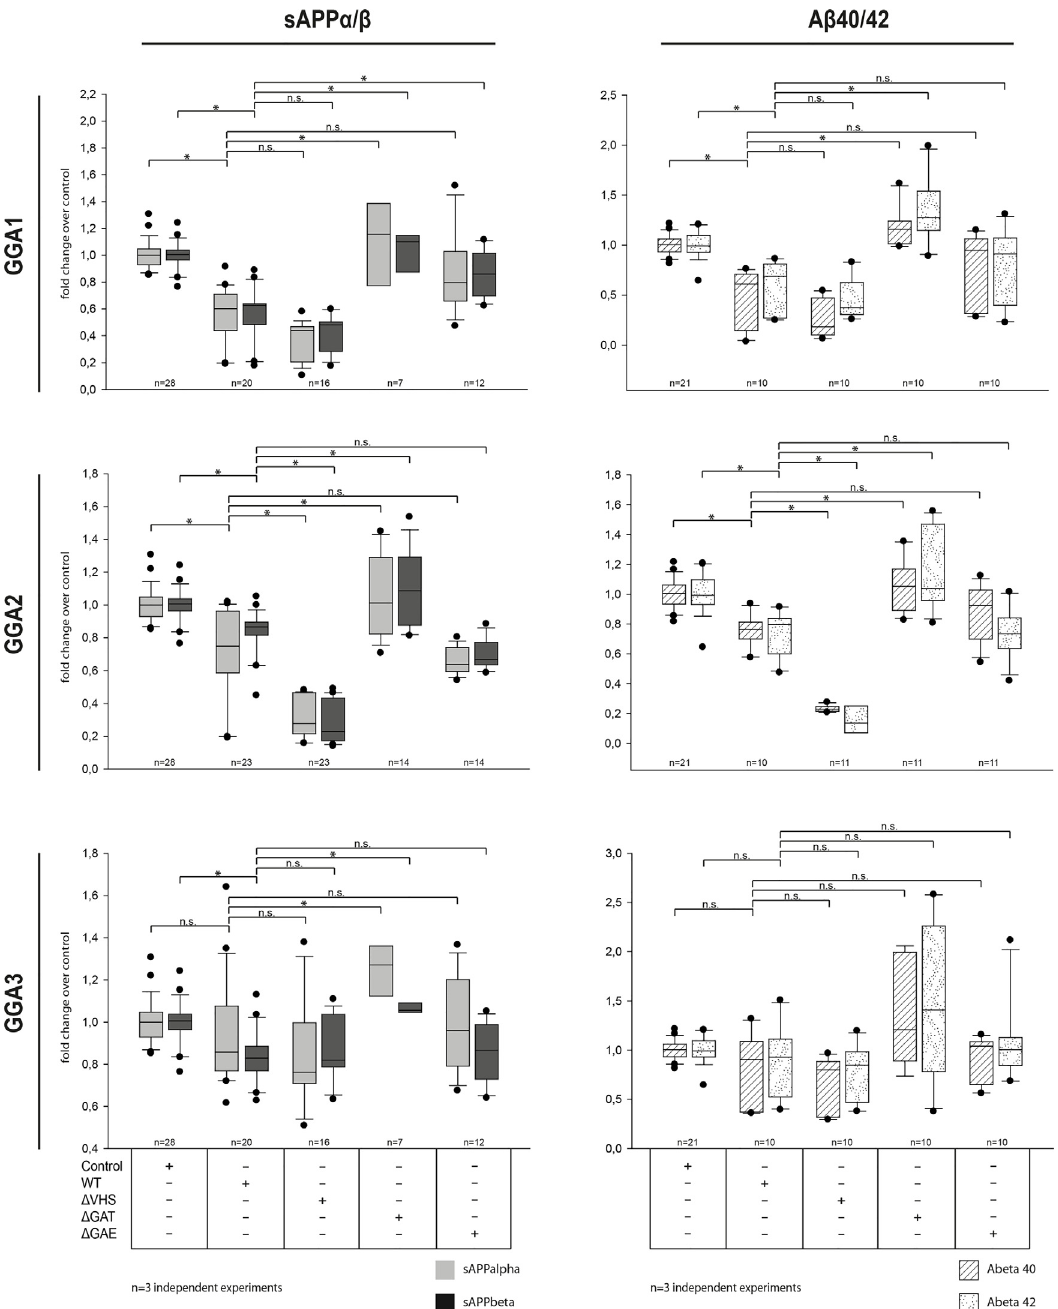
Fig 4. Deletion of GGA GAT and GAE but not VHS domain increases secretion of APP β -cleavage products. N2A cells were co-transfected with APP-GFP and BACE1-HA and either GGA1, 2, or 3_wt-myc or domain deletion mutants. After 24 h, sAPP and A β levels were measured in the conditioned media by using sAPP and A β ELISA kits (MesoscaleDiscovery). As shown previously, secretion of sAPP α and β were reduced in cells overexpressing GGA1, 2, or 3 _wt or- Δ VHS compared with controls (left panels). Additionally, A β 40 and A β 42 levels were also reduced in cells co-expressing GGA_wt or- Δ VHS. Deletion of the GGA-GAT domain completely abolished the effect of sAPPs as well as A β secretion. Deletion of the GGA1 GAE domain but not GGA2 or 3 significantly increased sAPP β levels compared with that of GGA_wt. Likewise, A β levels were increased for all three GGA GAE mutants, indicating altered APP processing due to altered BACE1-GGA interaction. Experiments were carried out in triplicate; shown are the results of n = 3 independent experiments. Statistical analysis was performed by using Kruskal-Wallis ANOVA on ranks and multiple comparison (Dunn ’ s method) ( * p <